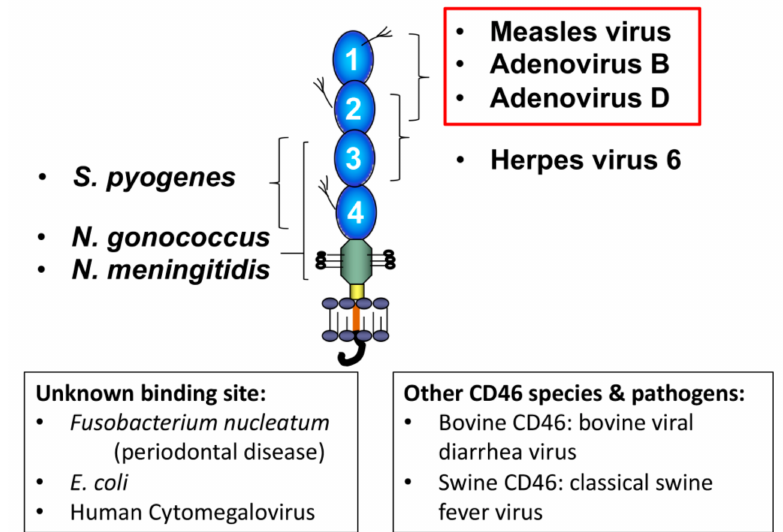
Figure 3. CD46 is a receptor for 10 human-specific pathogens; bovine and swine CD46 are also pathogen receptors. For seven of the human pathogens, the binding site has been identified (indicated above), including strains of measles virus and adenovirus. Two features make CD46 an attractive target for oncology applications: (1) it is overexpressed on many cancer cell types and (2) measles and adenoviral vectors can be constructed to target CD46 for cancer treatment. More than 20 CD46-targeted cancer treatments trials are currently being